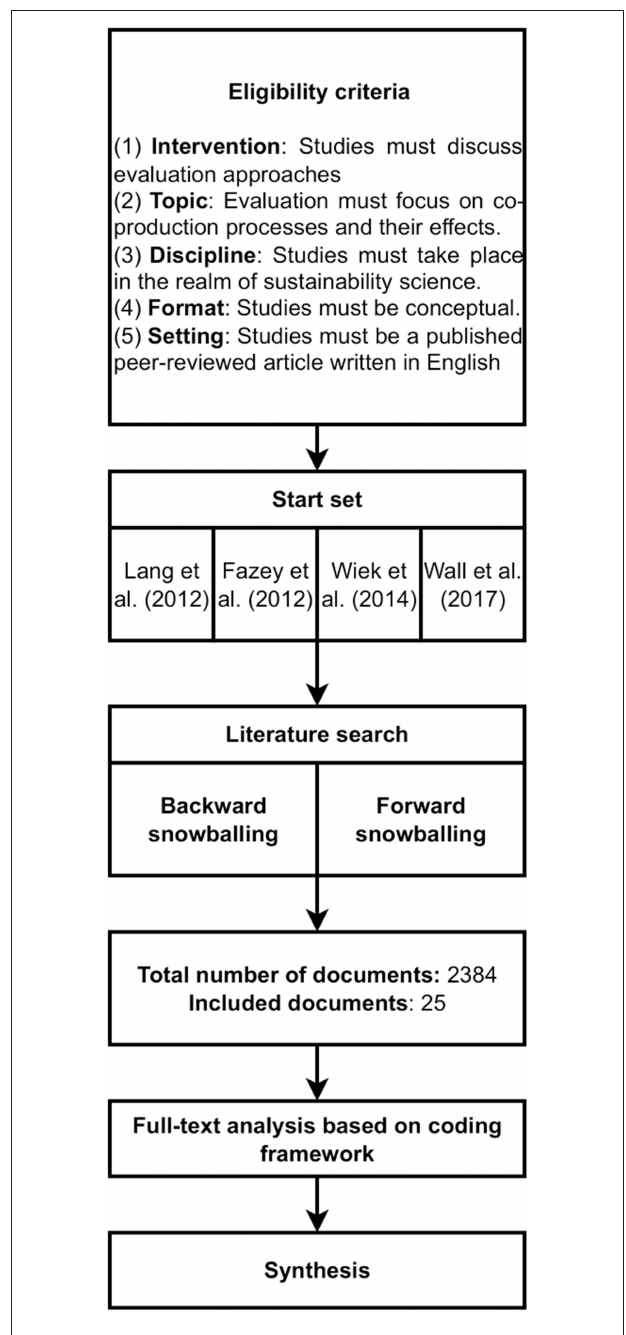
FIGURE 1 | Literature review